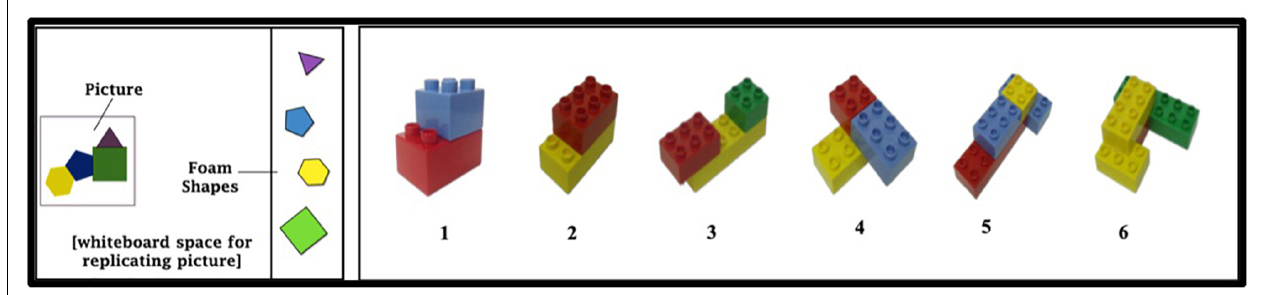
FIGURE 1 | The left side of the figure is a schematic of one trial of the 2D TOSA. The right side of the figure includes the block constructions used for each 3D TOSA trial. The number below the construction indicates on which trial each construction was used (Verdine and Golinkoff,